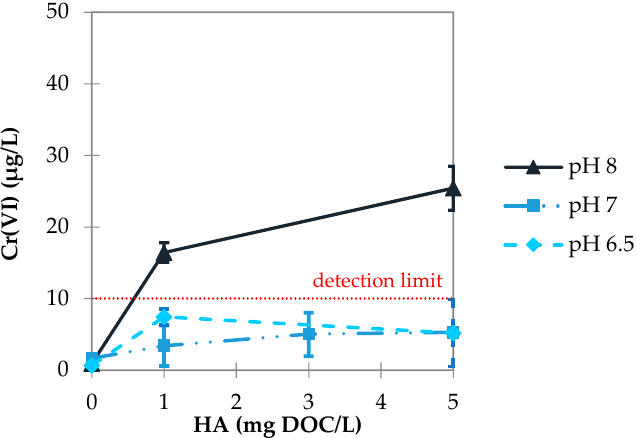
Figure 5. Cr(VI) residual concentrations as a function of HA presence (concentrations: 0, 1, 3, 5 mg DOC/L) at pH values 6.5, 7, and 8 at for Fe(II) dosage 2 mg/L. Mean values with vertical bars indicate the range of values. The results were obtained by using both set-ups A and B.